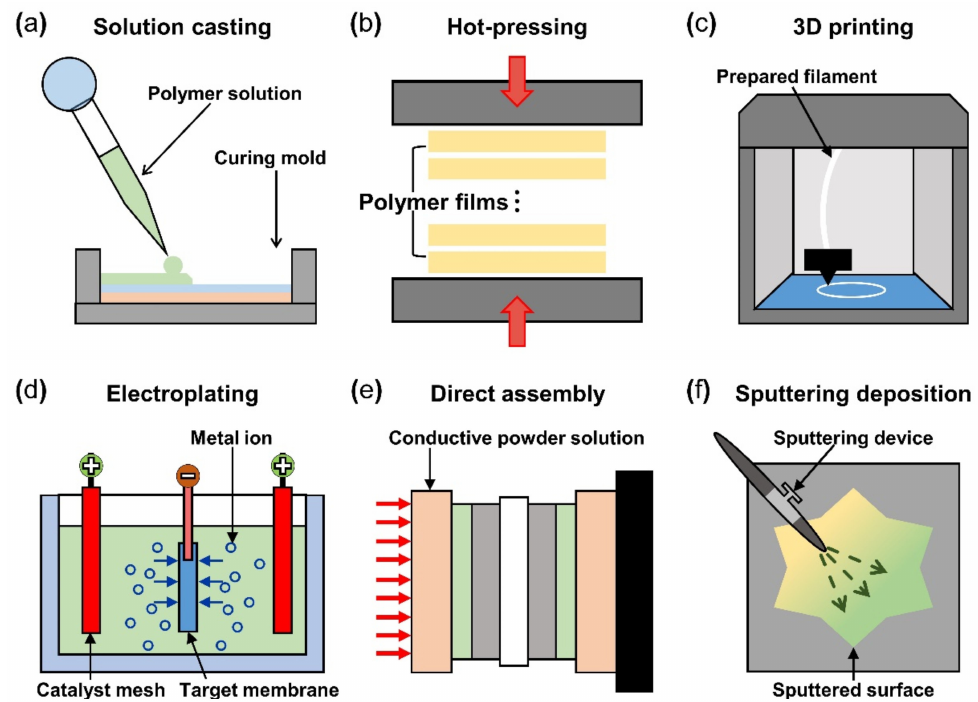
Figure 6. Schematics of IPMC polymer membrane manufacturing method, ( a ) solution casting method, ( b ) hot pressing method, and ( c ) 3D printing method. IPMC electrode manufacturing method ( d ) electro plating method, ( e ) direct assembly process method, and ( f ) sputtering deposition method. Adapted from Yang et al.